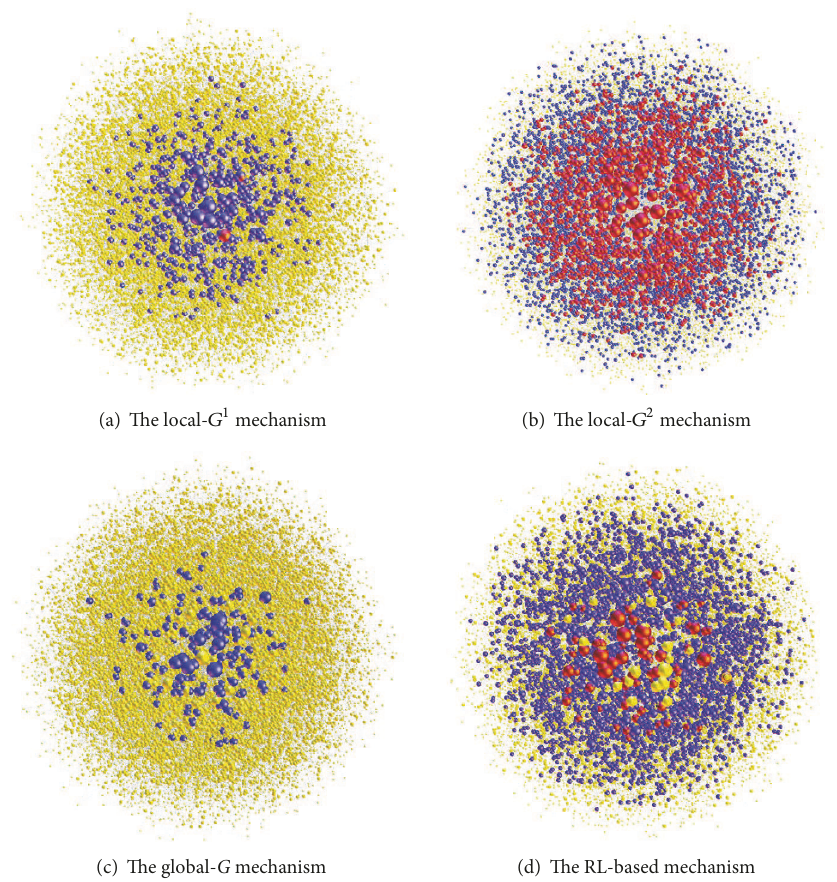
Figure 7: The snapshots of individuals’ vaccinating possibilities in a scale-free network under (a) the local- 𝐺 1 mechanism, (b) the local- 𝐺 2